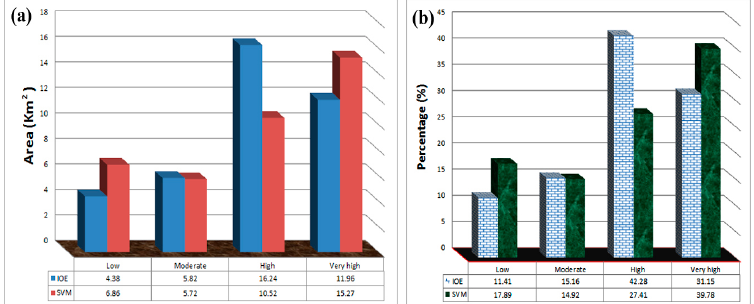
Figure 9. Histograms representing the distribution of observed landslides falling into various susceptibility classes of landslide susceptibility mapping (LSM) extracted from SVM and IOE models: ( a ) area (km 2 ) of landslides that occurred; ( b ) percentage (%) of landslides that